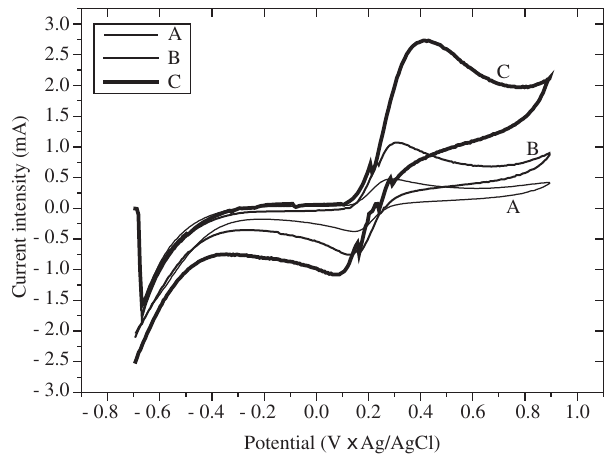
- 0.8 - 0.6 - 0.4 - 0.2